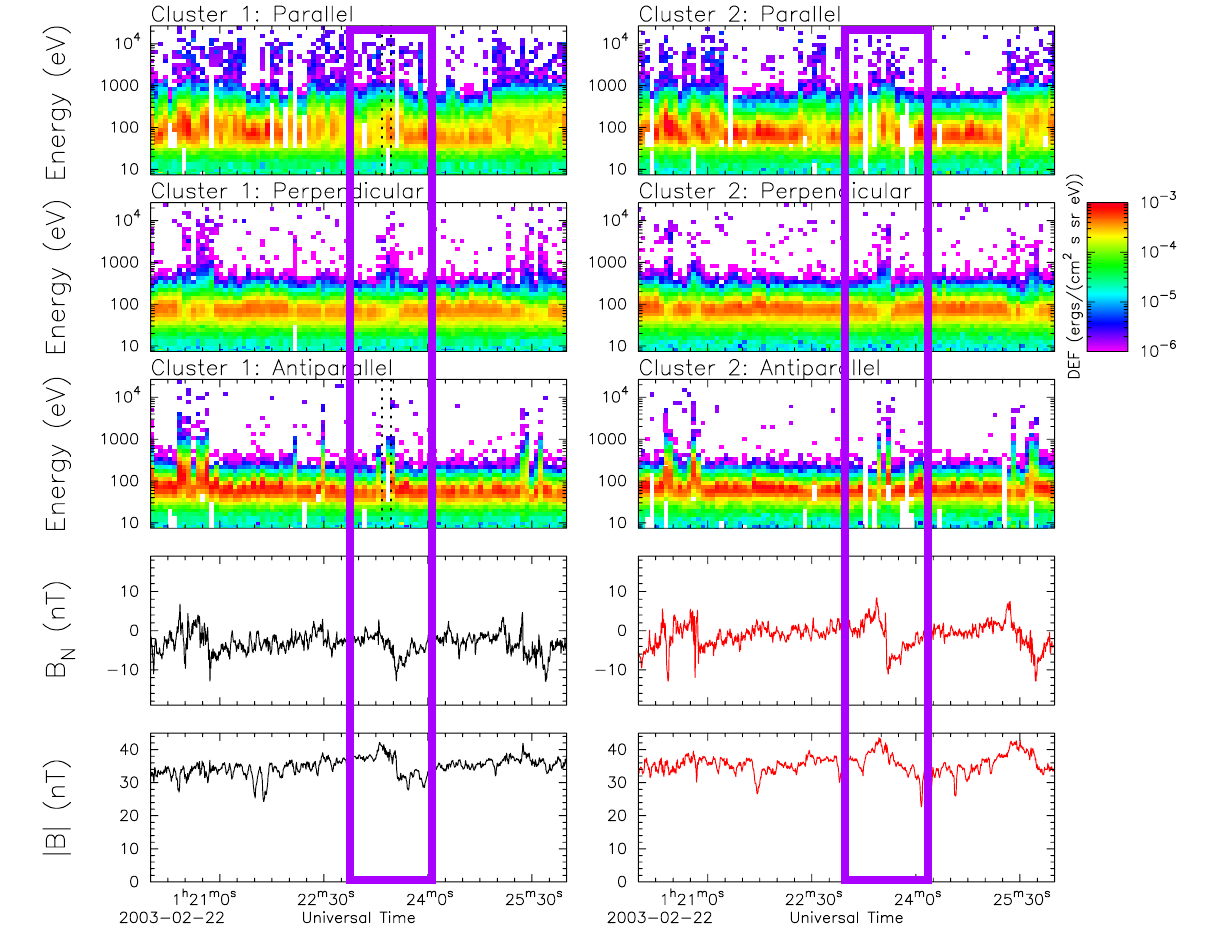
Fig. 11. PEACE electron data from Cluster 1 (left) and Cluster 2 (right) for FTE 161 (22 February 2003, 01:23 UT). Each half of the figure adopts the same format as the Fig. 10a. The dotted lines indicate the slices of the pitch angle distributions shown in Fig.